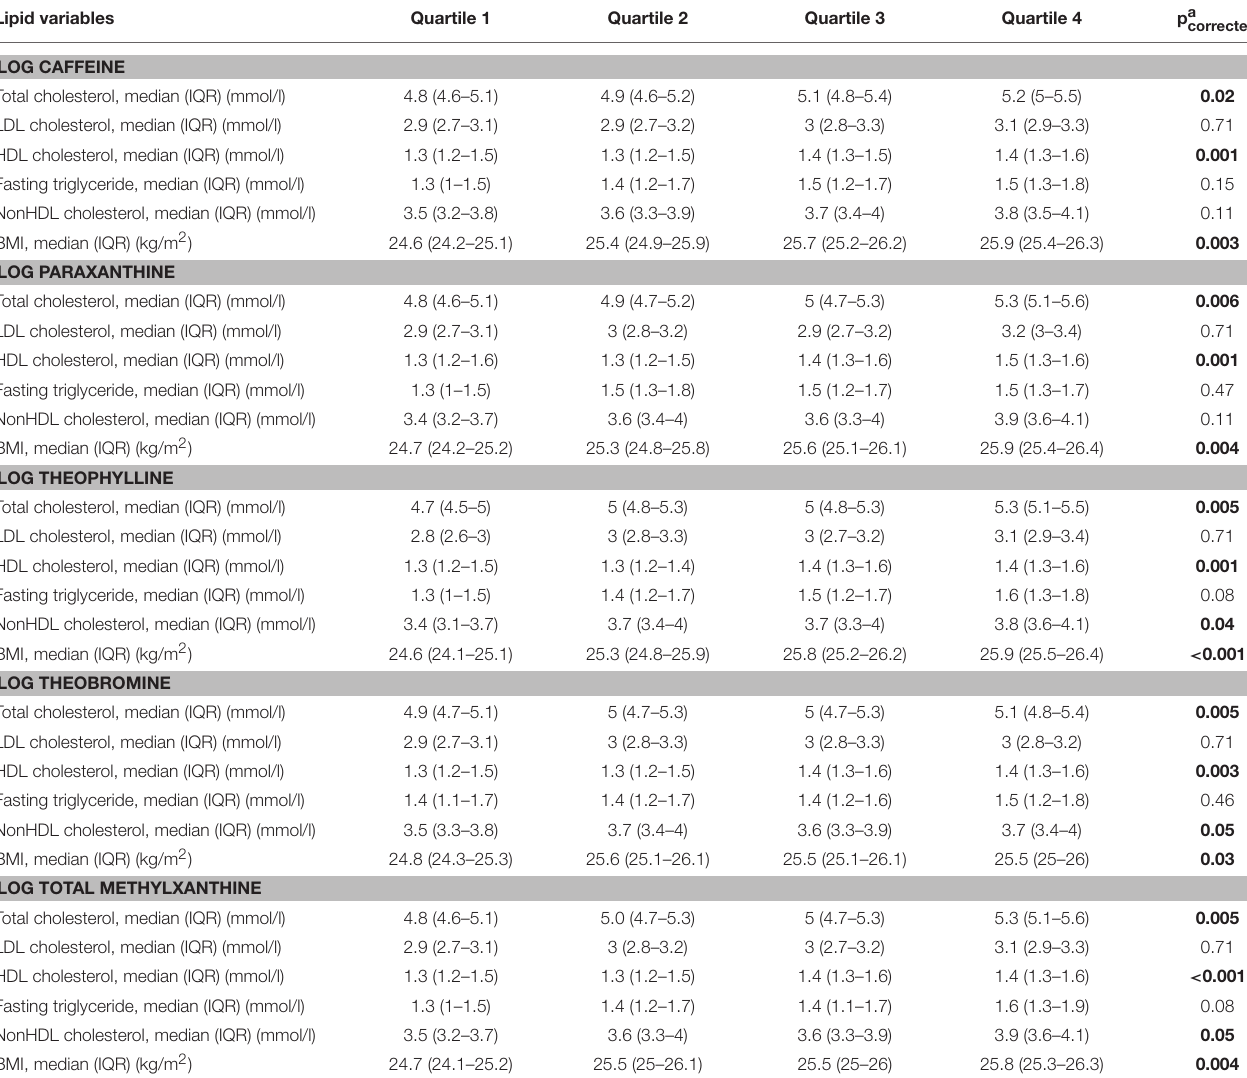
TABLE 3 | Adjusted median of plasma lipid levels according to quartiles of methylxanthine levels. Lipid